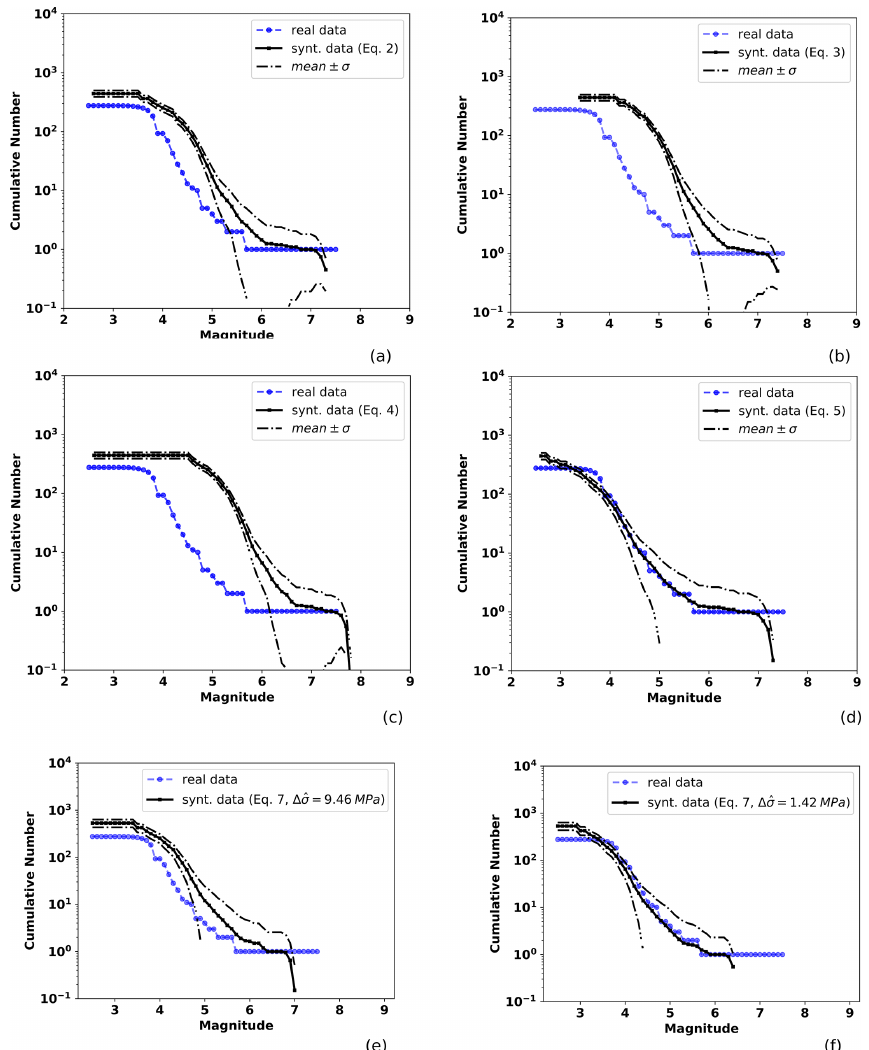
Figure 7. Observed and TREMOL synthetic frequency–magnitude curves for SA region 4 (Table 1). The solid black line indicates the mean after 20 realizations and the broken lines the standard deviation. The blue line is the seismicity curve for events from 1988 to half a year before the mainshock date (20 March 2012), including earthquakes that occurred at the depth range mentioned in the text. Other features as in Fig.